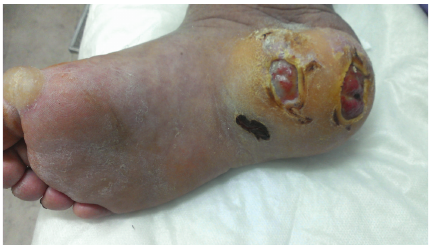
Figure 1: Two wounds on the right heel bones.